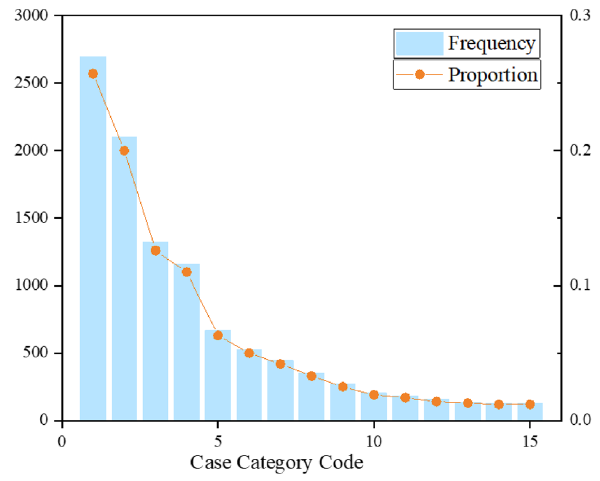
Figure 4. Frequency distribution of the top 15 most frequent